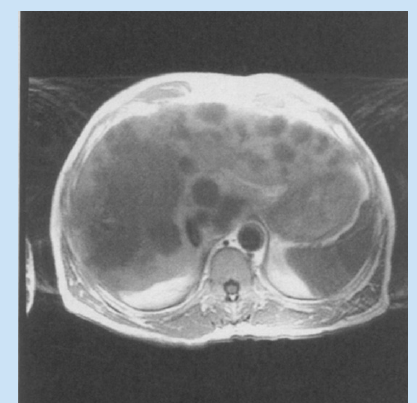
Fig. 3a. MRI confirming multiple hepatic cysts with low signal on T1-weighted images.